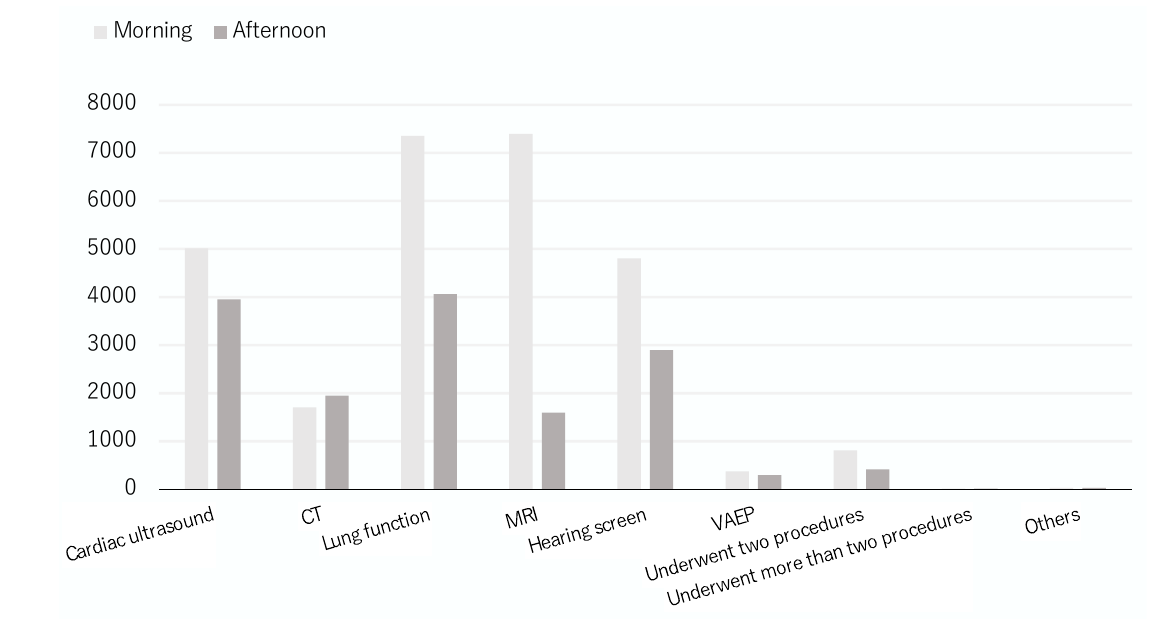
Figure 2. The distribution of procedures between the two cohorts . Table 1. The demographic characteristics of the two cohorts.